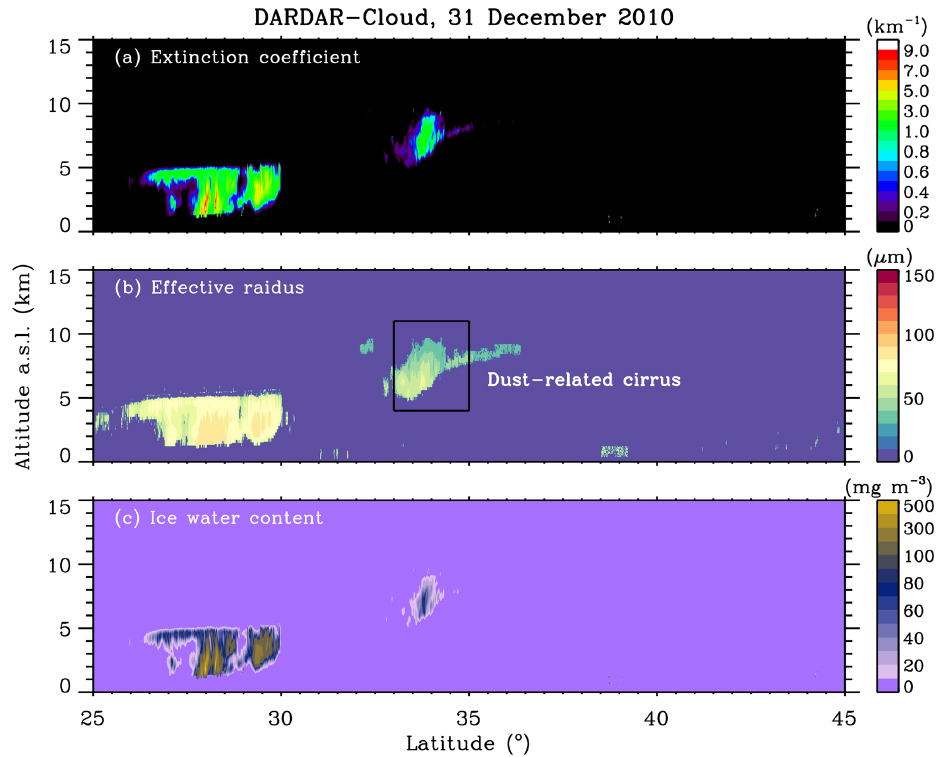
Figure 9. Altitude–orbit cross section of the (a) cloud extinction coefficient, (b) cloud particle effective radius, and (c) ice water content from the DARDAR-Cloud product on 31 December 2010. The footprint of the satellite is the same as shown in Fig.